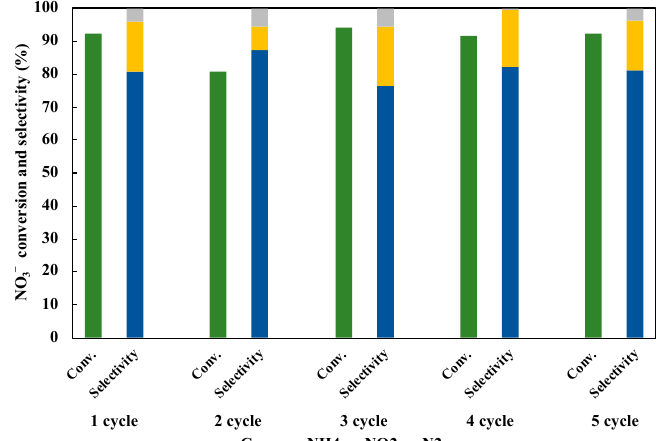
Figure 12. Reusability of 1 wt% Cu 0.9 Ag/TiO 2 in 45 mL of 50 ppm NO 3 − aqueous solution including 10 vol% of CH 3 OH under UV irradiation for three hours for five cycles.